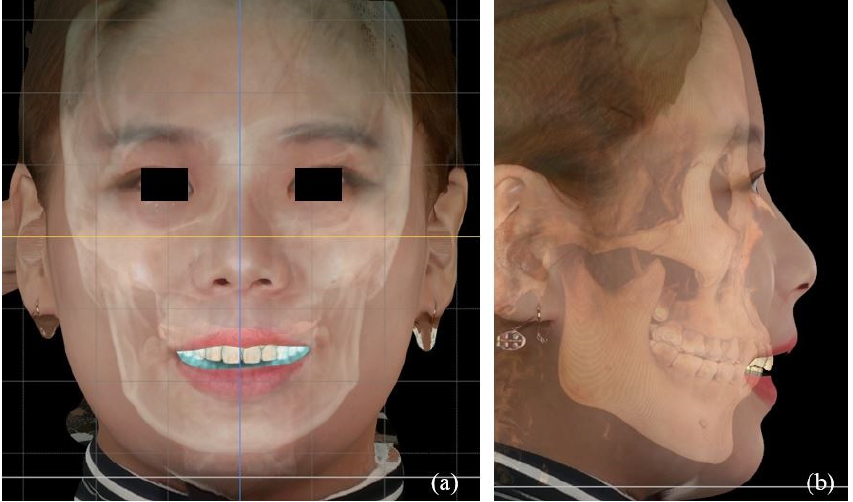
Figure 2. A digital twin reconstructed by the fusion of facial scan and cone-beam computed tomography images. ( a ) Coronal view of the face. ( b ) Sagittal view of the face.